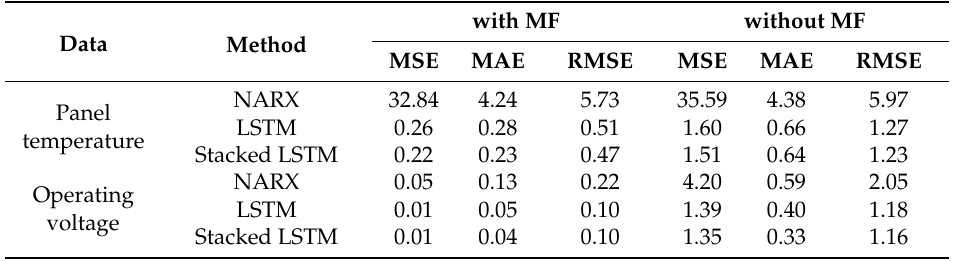
Table 1. The resulting MSE, MAE, and RMSE with di ff erent predictors for the panel temperature and operating voltage. MF represents the median filter, and NARX represents the nonlinear autoregression with the external input neural